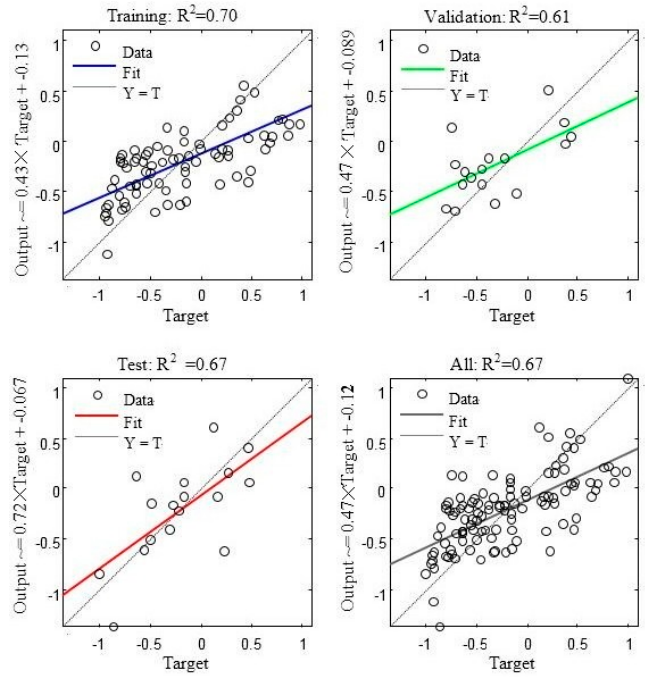
Figure 11. Fitting of the BP neural network to the TN effluent concentrations.